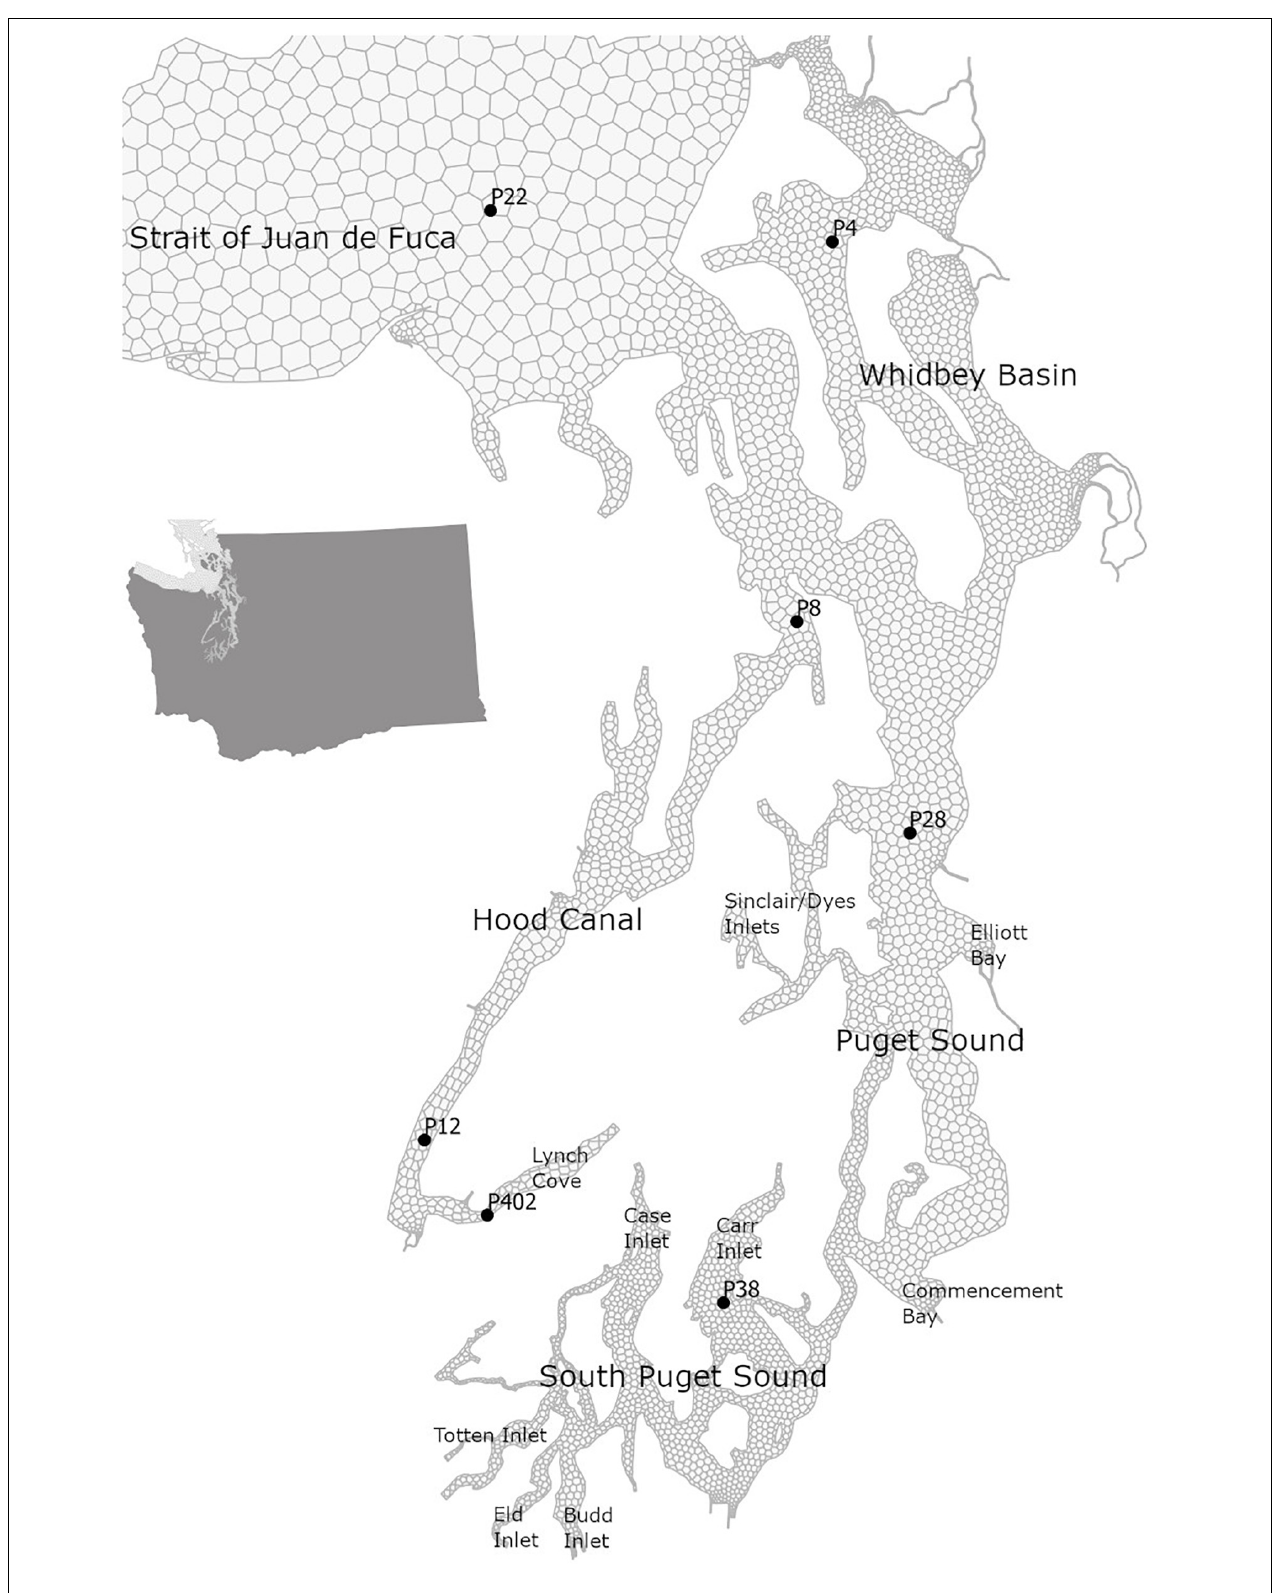
FIGURE 1 | Map of the Salish Sea with selected stations in its southern part of Puget Sound with Main Basin (P28) that are part of the OA monitoring efforts in Washington state.